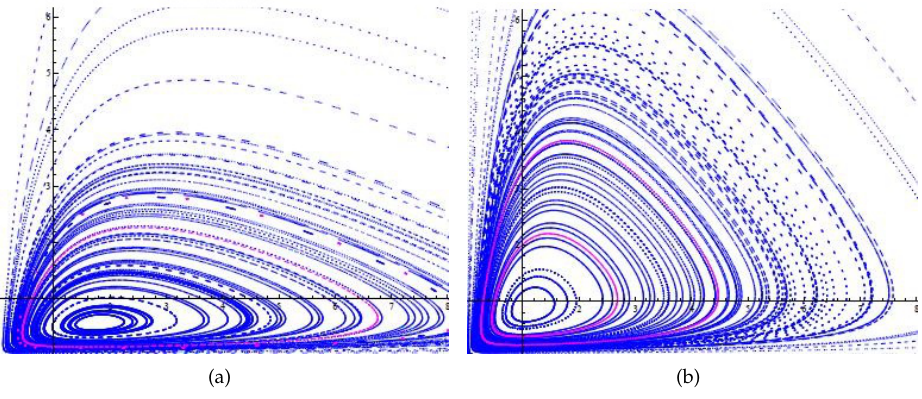
Figure 1. Some orbits of the map T for ( a ) a = 0.5 and ( b ) a = 1.5. The plots are generated by Dynamica 3 [6].